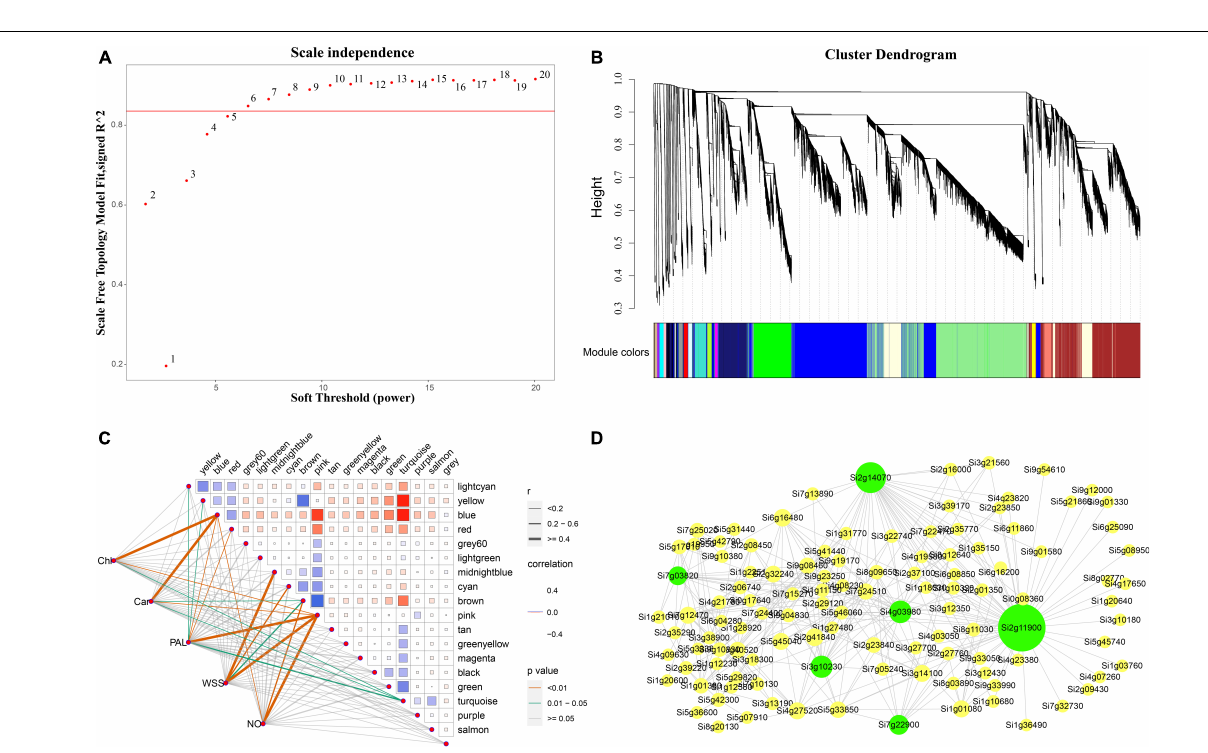
Frontiers in Plant Science |